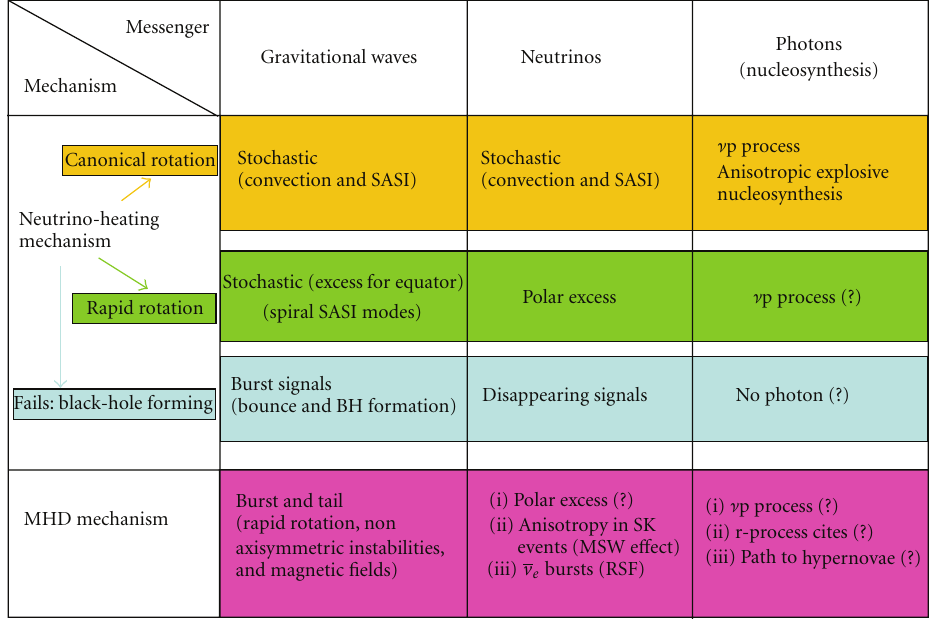
Table 2: A summary illustrating the candidate supernova mechanisms (vertical direction in the Table) and their expected features of the emergent multimessengers (horizontal direction). Regarding the photon messengers, possible signatures associated with nucleosynthesis are only partly presented (see Section 1 for a number of important findings regarding the light-curve and spectra